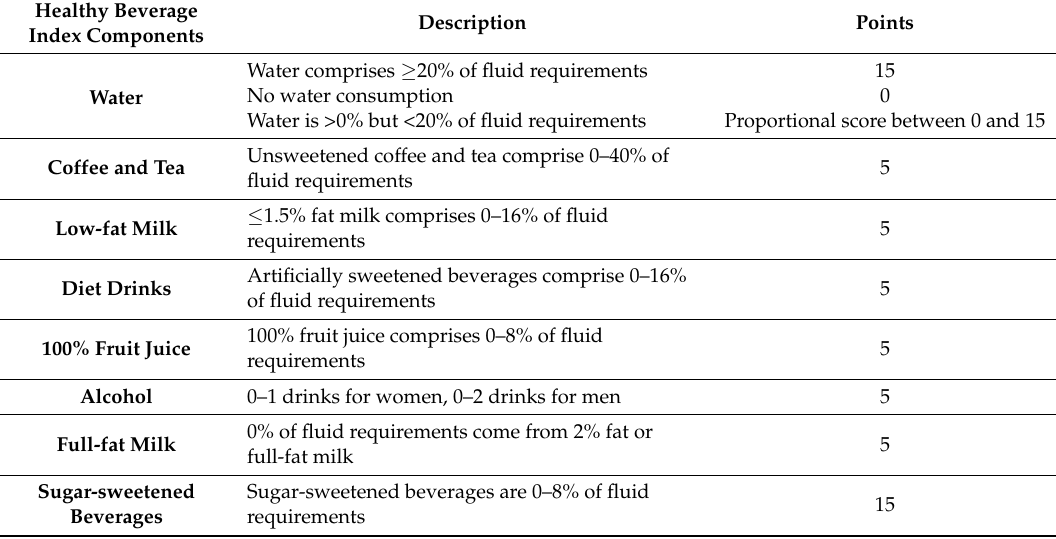
Table 1. Healthy Beverage Index (HBI) components a